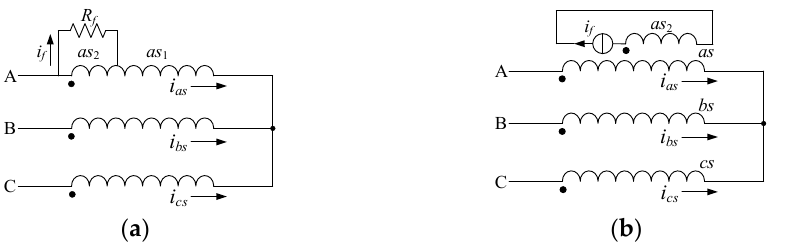
Figure 1. ( a ) The equivalent winding structure and ( b ) equivalent fault separation structure of Y-connected stator windings with interturn short-circuit